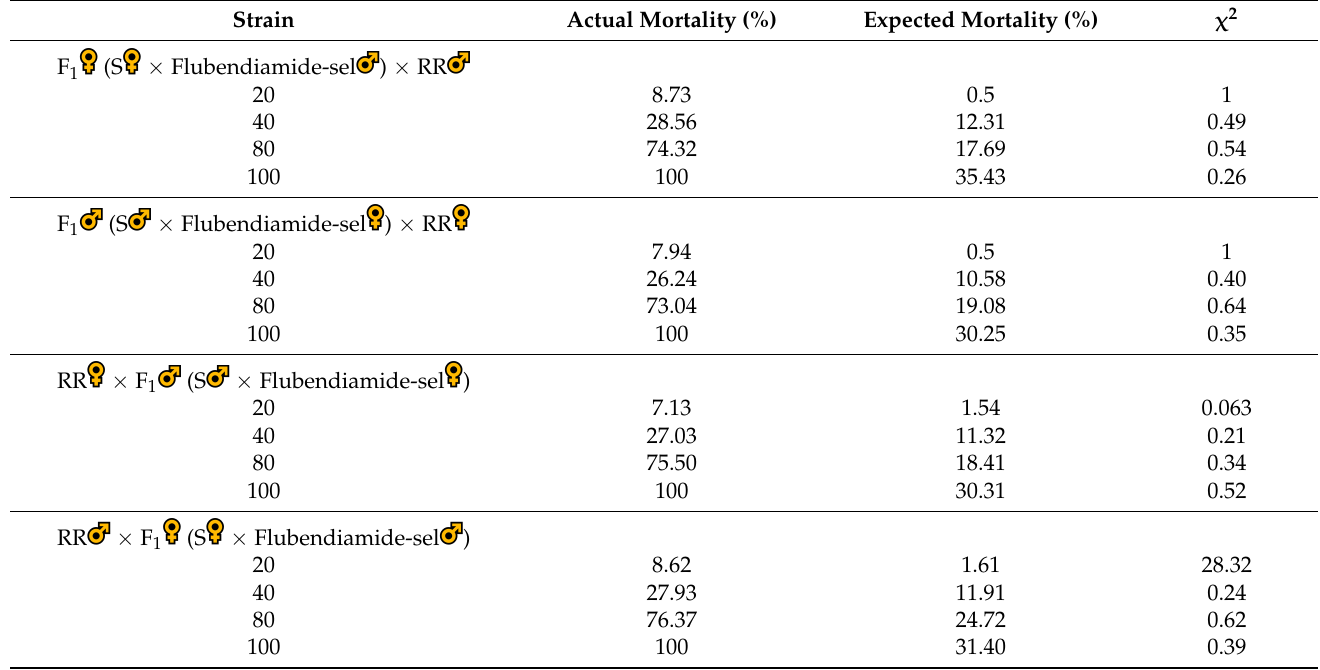
Table 7. Dose dependent effective dominance of flubendiamide-sel population of Tuta absoluta.